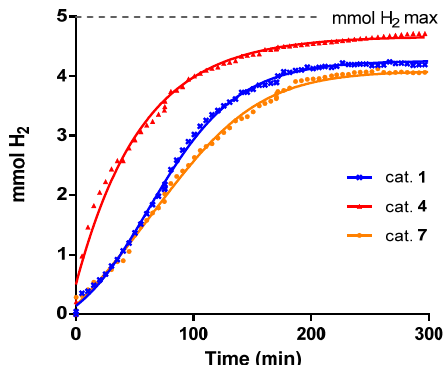
Figure 4. Evolution of H 2 (g) vs. time for the dehydrogenation of glycerol to lactic acid catalyzed by 1 , 4 and 7 (0.2 mol%) at 130 °C. The produced hydrogen in the catalytic tests is consistent with the 1 , 4 and 7 (0.2 mol%) at 130 ◦ C. The produced hydrogen in the catalytic tests is consistent with stoichiometric limit of added KOH (5 mmol of H 2 (g), horizontal line).